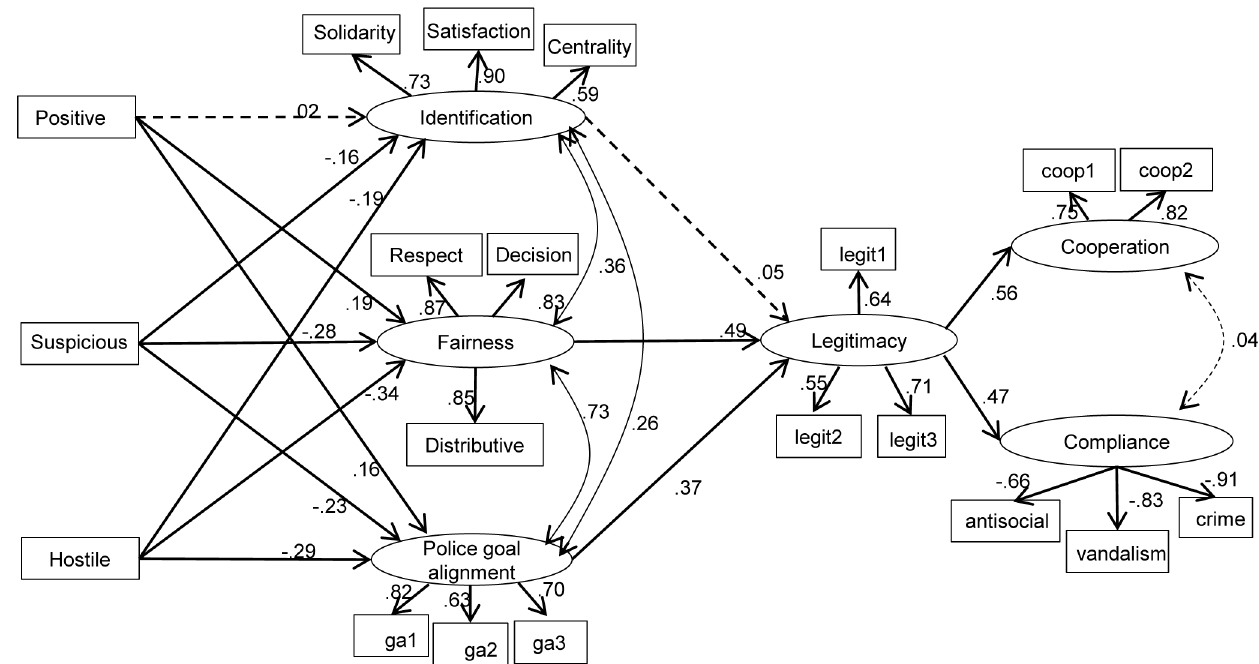
Fig 7. Structural equation model specifying mediated paths from experience to cooperation and compliance.